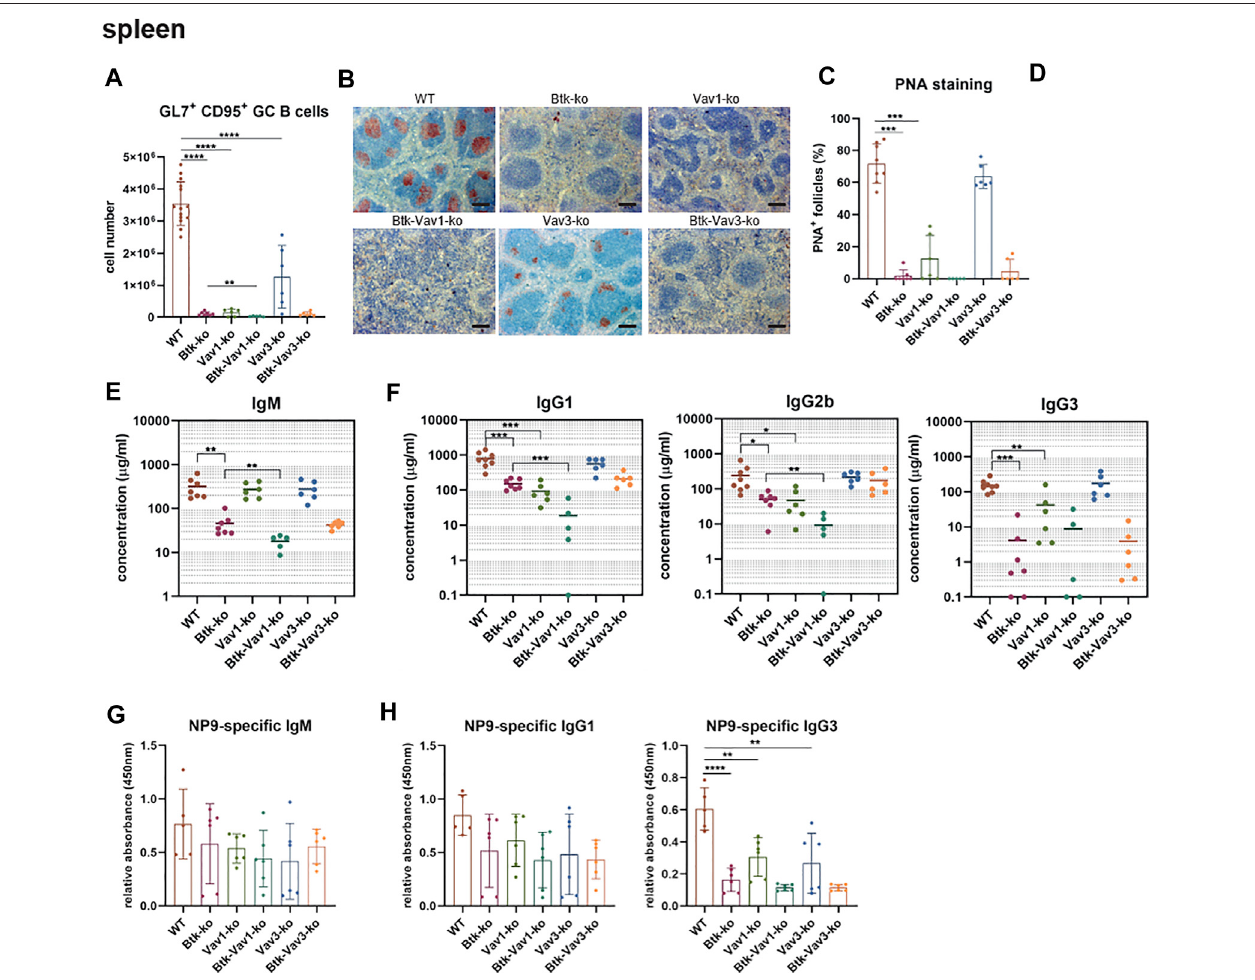
FIGURE6| Vav1de fi ciencyimpairsef fi cientGCformationandimmunoglobulinproduction.MicewereimmunizedwithSRBCsandGCformationwasassessedby fl owcytometryandimmunohistochemistryandimmunoglobulinserumtitersweredeterminedbyELISA. (A) Statisticsof fl owcytometricanalysesofGC B(GL7 + CD95 + ) cellnumbersinthespleenareshown. (B) RepresentativeimmunohistochemicalstainingofPNA + GCsforeachgenotypeandareshown.Scalebarsindicate200 µm (C) Statistical analyses showing ratio of PNA + GCs/total follicles stained by immunohistochemistry. (D) Statistical analysis showing GC size of WT ( n = 10) and Vav3- single knockouts ( n = 5). Size ofGCs of three imagesections for each animalwasmeasured. The mean ofall three analyzed image sections for each mouse is depicted. (E) Statistical representation of IgM serum concentrations (µg/ml) determined relative to a standard IgM. (F) Statistical representation of IgG1, IgG2b and IgG3 serum concentrations (µg/ml) determined relative to corresponding standard antibodies. (G,H) Mice were immunized with NP-KLH to determine levels of antigen-speci fi c IgM (G) aswellasIgG1 and IgG3 (H) .Each point representsdatafromasinglemouse. Datain thegraphsareshownasmeans±SD(n=at least 5mice